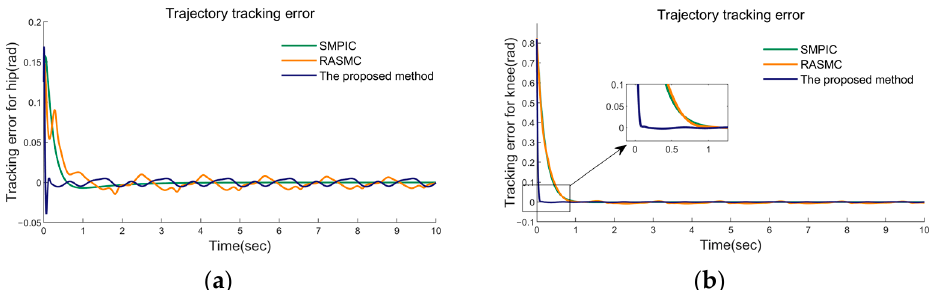
Figure 10. The tracking error of the joints. ( a ) the tracking error of θ 1 under case 1 condition; ( b ) the tracking error of θ 2 under case 1 condition